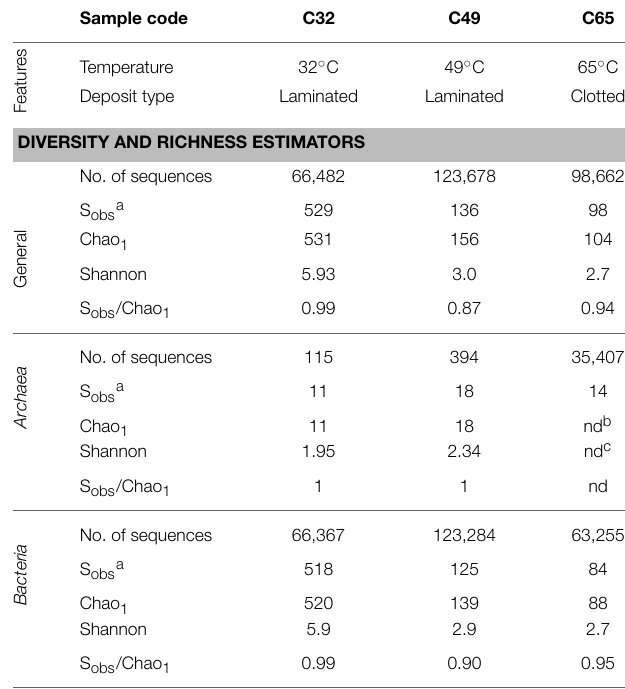
TABLE 1 | Diversity and richness estimators for sequencing